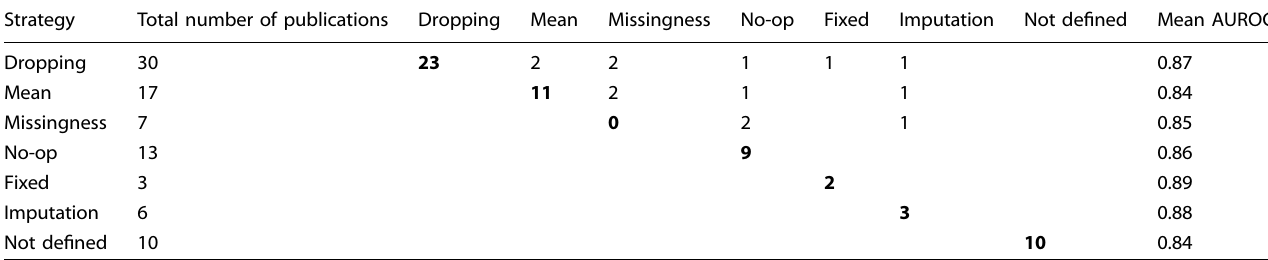
Table 2. Missing data strategies applied in the reviewed publications.